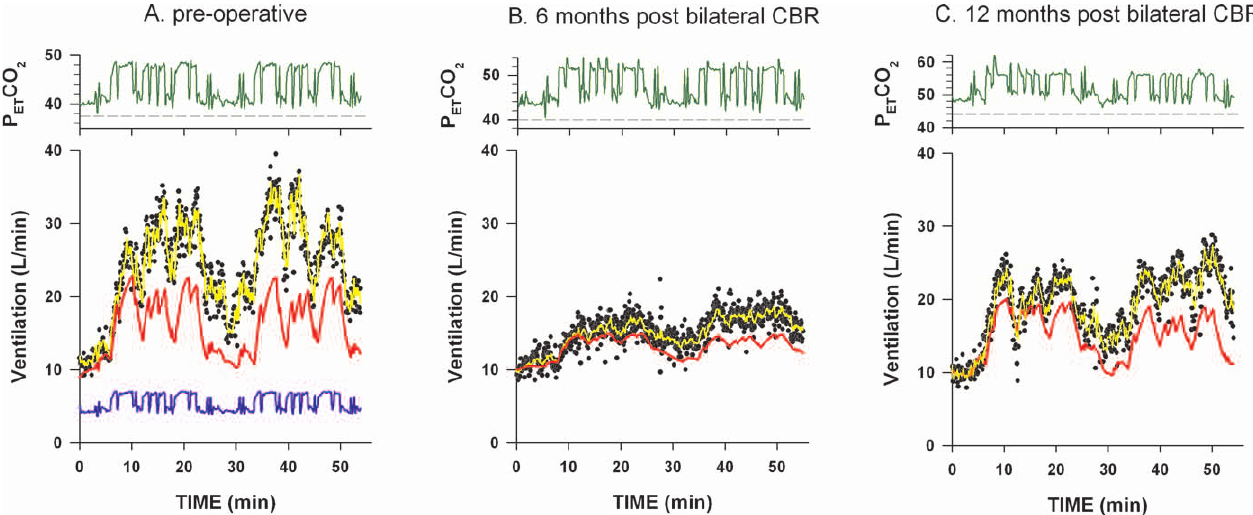
Figure 5. The Dynamic Ventilatory Response to CO 2 in Patient 2 Response was monitored before resection of the carotid bodies (A), 6 mo after bilateral carotid body resection (B), and 1 y after bCBR (C). The applied multifrequency binary sequence is shown on the top of each graph (green; units mm Hg; the dashed lines represent resting P ET CO 2 values). The breath- to-breath ventilation is depicted by the grey dots. The ventilatory response is separated into a slow component originating at the central chemoreceptors (red) and a fast component originating at the peripheral chemoreceptors (blue). The sum of these two components plus a trend term (not shown) and the (parallel) noise corrupting the data, is the yellow line through the measured data points. The analysis shows that 6 mo after resection of the two carotid bodies the peripheral component was not present and the central component initially reduced to about 40% of preoperative values. Six months later, the central component had increased to about 70% of preoperative values. Parameter values are given in Table 2.